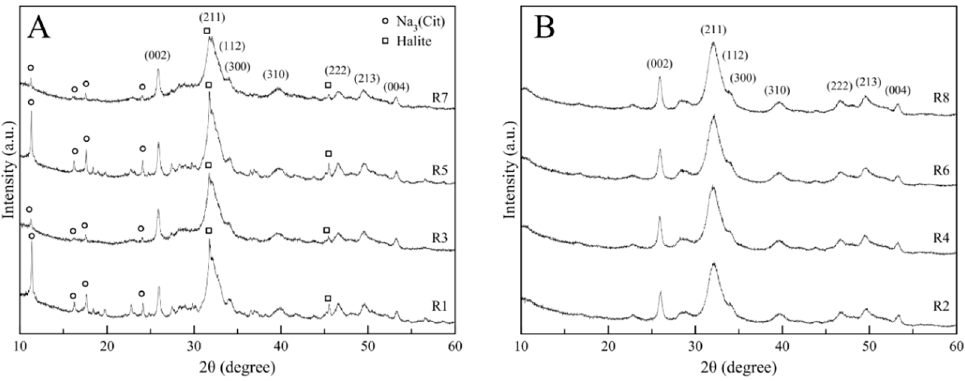
Figure 2. Powder X-ray diffraction (PXRD) patterns of the CaP NPs samples. ( A ) Odd-numbered runs and ( B ) even-numbered runs. Table 2. Composition and crystallographic parameters of CaP NPs samples.